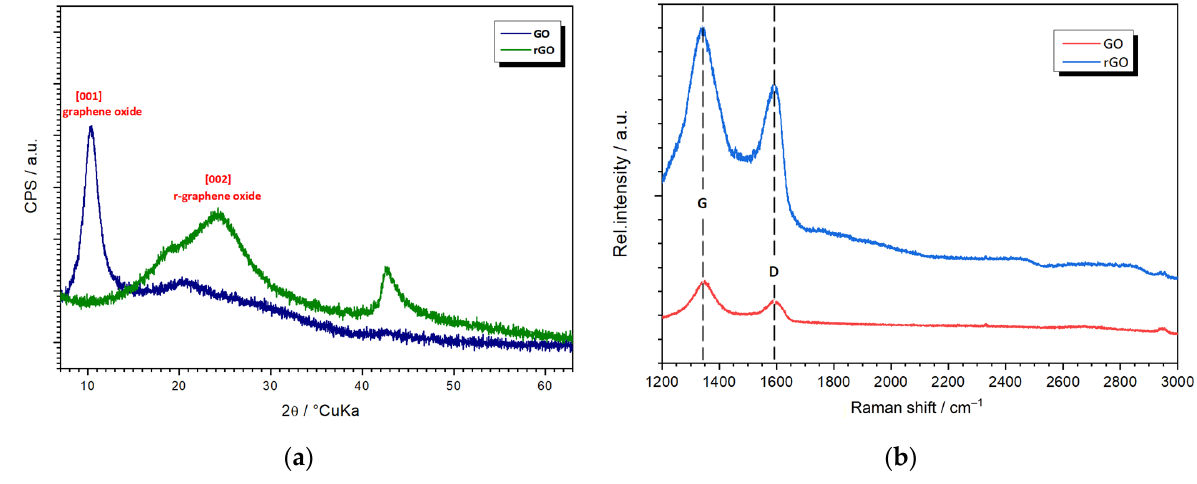
Figure 1. ( a ) X-ray diffraction patterns, and ( b ) Raman spectra of GO and rGO.